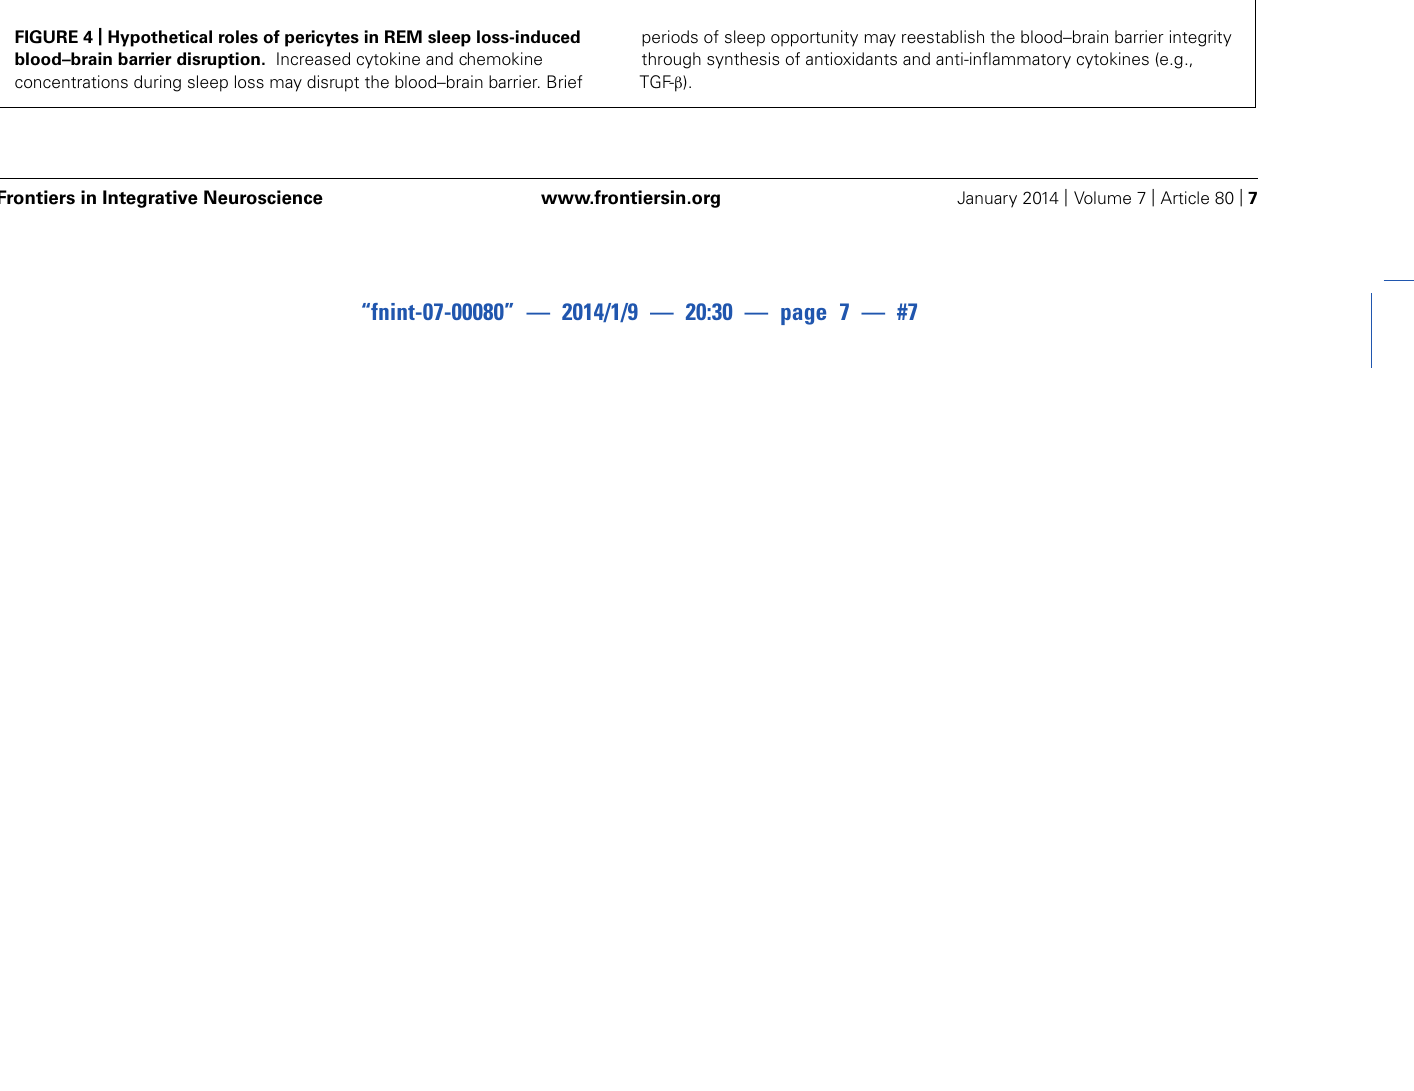
FIGURE 4 | Hypothetical roles of pericytes in REM sleep loss-induced blood–brain barrier disruption. Increased cytokine and chemokine concentrations during sleep loss may disrupt the blood–brain barrier. Brief